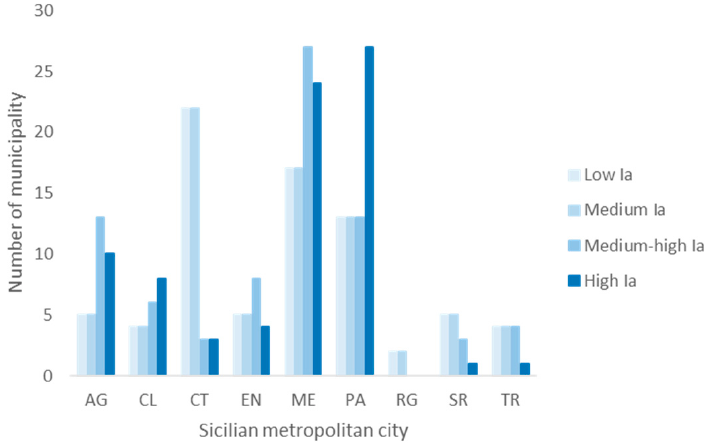
Figure 16. Number of municipalities by class of abandonment in Sicilian metropolitan cities. (Au- thors’ elaboration.)